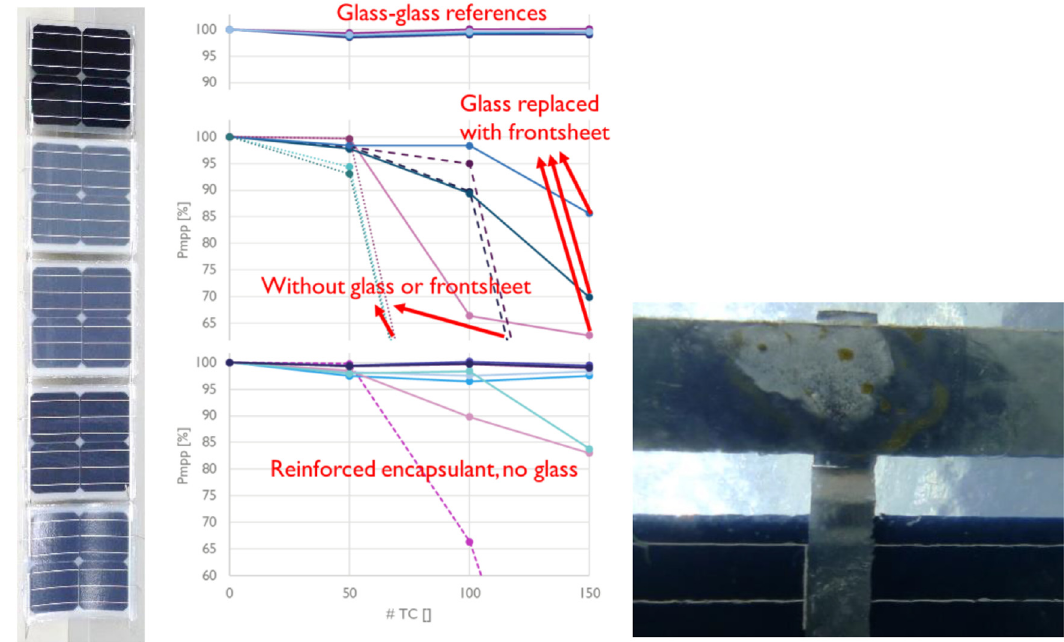
Fig. 3. Thermal cycling (TC) of 2 (cid:1) 2 laminates: comparison graphs (center) between degradation in glass-glass laminates (top), versus glassless laminates (center, dotted lines represent samples with only encapsulant, so no cover material as glass or front- or backsheet) and GF-reinforced encapsulants (bottom, with and without cover material); picture of partial ribbon breakage as failure mechanism (right).